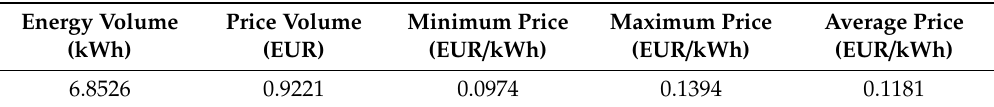
Table 6. Local market session aggregate results.